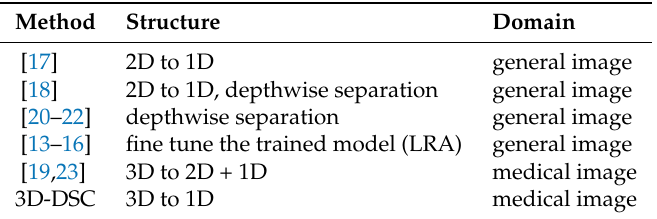
Table 1. General comparison with other related methods. LRA, Low Rank